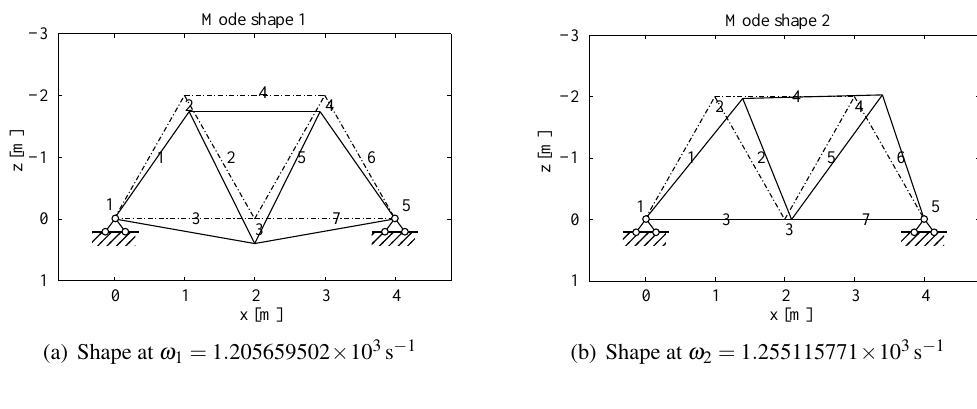
Fig. 14. Transversal displacement shapes of bars for seven bar truss modes. ( Continued on the next page.